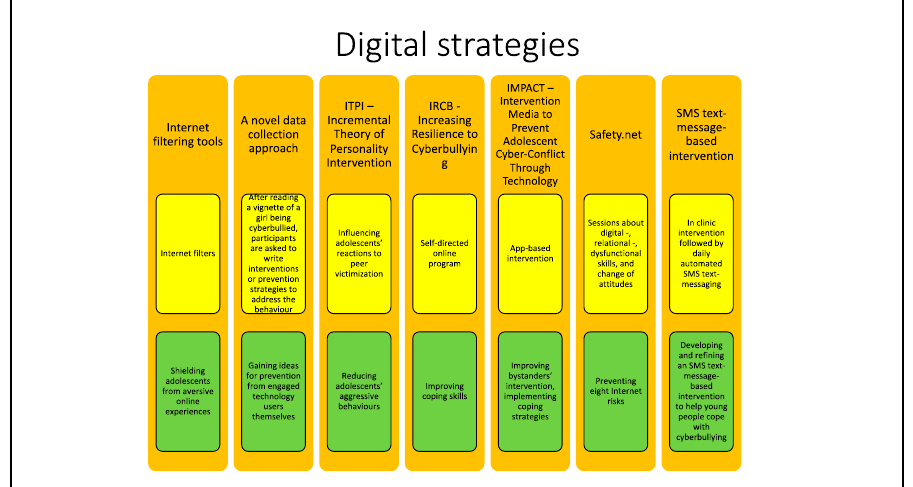
Figure 4. This figure summarizes descriptions and objectives of the digital strategies that will be presented below. The name of the strategy is reported in orange boxes. Yellow boxes contain different strategies’ descriptions, while objectives are stated in the green boxes.